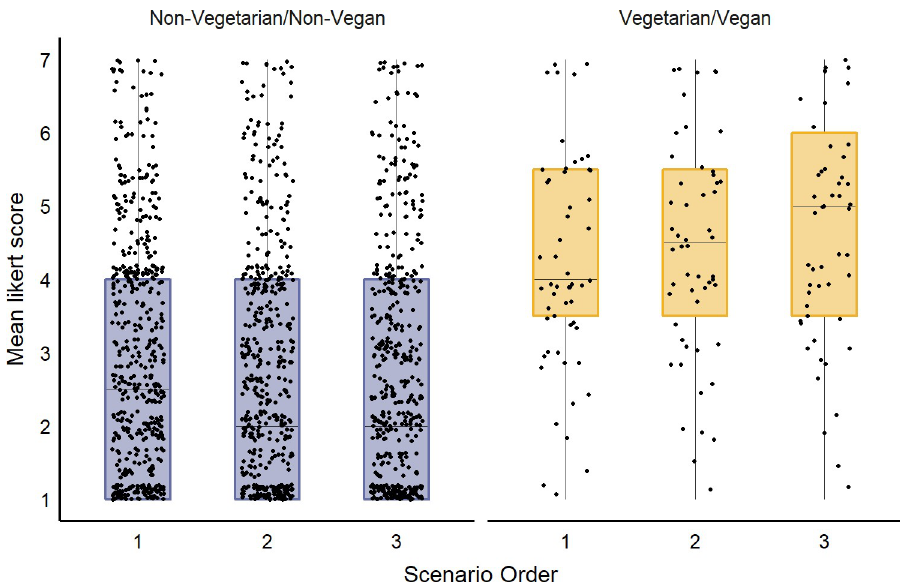
Fig 1. Support for milk alternatives in relation to participant diet and the order in which they encountered treatments. Mean 7-point Likert (where 1 = strongly oppose; 7 = strongly support) averaged across plant-based and cowless milk questions, shown separately for participants who described themselves as vegan or vegetarian (n = 59) and for those who did not (n = 591). Results are also shown in relation to the order that participants encountered the 3 scenarios (one of two calf-rearing treatments, horn removal and pasture access). The central line in the boxplots shows the median, the limits of the box show the 1 st and 3 rd quartiles, and the whiskers show the 10 th and 90 th percentiles.